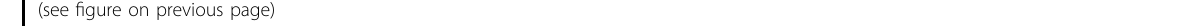
Fig. 1 Structural mechanism of D ′ D3 dimer formation. a The domain arrangements of full-length VWF. b Identi fi cation of disul fi de-linked peptides from the D ′ D3 dimer interface. The D ′ D3 dimers were cleaved by CNBr and analyzed by mass spectrometry with Cys 1097 – Cys 1097 ′ peptides con fi rmed by the MS/MS spectrum. c Identi fi cation of free cysteines in monomeric D ′ D3. D ′ D3 monomers were sequentially modi fi ed by NEM and 4- VP, then treated with protease Asp-N and analyzed by LC-MS. d Cryo-EM structure of the repeating unit containing one VWF D ′ D3 dimer (cyan and pink) and one D1D2 dimer (wheat), which mirrors the repeating unit of MUC2. Other intermolecular interfaces in the complex are shown in Supplementary Fig. S8. e The dimer shown in the cartoon with the VWD3 module of D3 (left chain) colored in brown, C8-3 in cyan, TIL3 in purple, and E3 in yellow and the other D3 chain in gray. f The electron densities covering the key disul fi de bonds Cys 1097 – Cys 1097 ’ and Cys 1091 – Cys 1099 near the D ′ D3 dimeric interface are shown as gray mesh contoured at 1.5 rmsd. g The overlaid structures of D ′ D3 monomer (gray) and dimer (cyan) showing the loop linking residues 1091 and 1099 fl ips up and stacks with the same loop from the other molecule in the dimer (Supplementary Fig. S5). h Relative positions of cysteines Cys 1091 , Cys 1097 , and Cys 1099 in D ′ D3 monomer and dimer. i A diagram showing D ′ D3 monomer equilibrating in con fi gurations with either Cys 1097 or Cys 1099 free. Only the main form with free Cys 1099 was identi fi ed in the previous study possibly due to the lower sensitivity of the equipment or the lower amount of protein used. In the presence of VWF D1D2 domains at mild acidic pH, only D ′ D3 monomers with Cys 1091 – Cys 1099 bond could readily bind each other complimentarily and allow intermolecular Cys 1097 – Cys 1097 ’ disul fi de bond